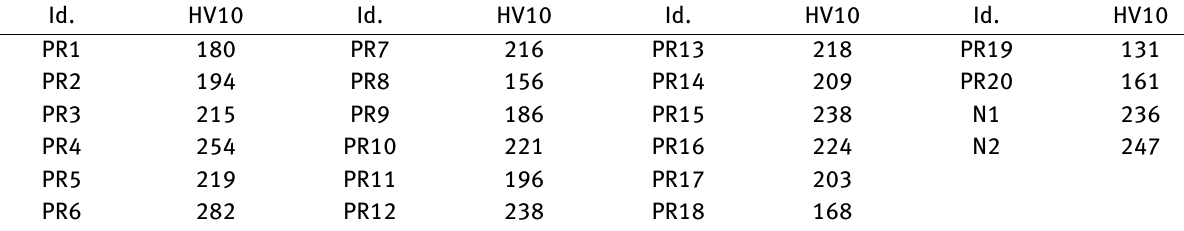
Table 3: Vickers hardness